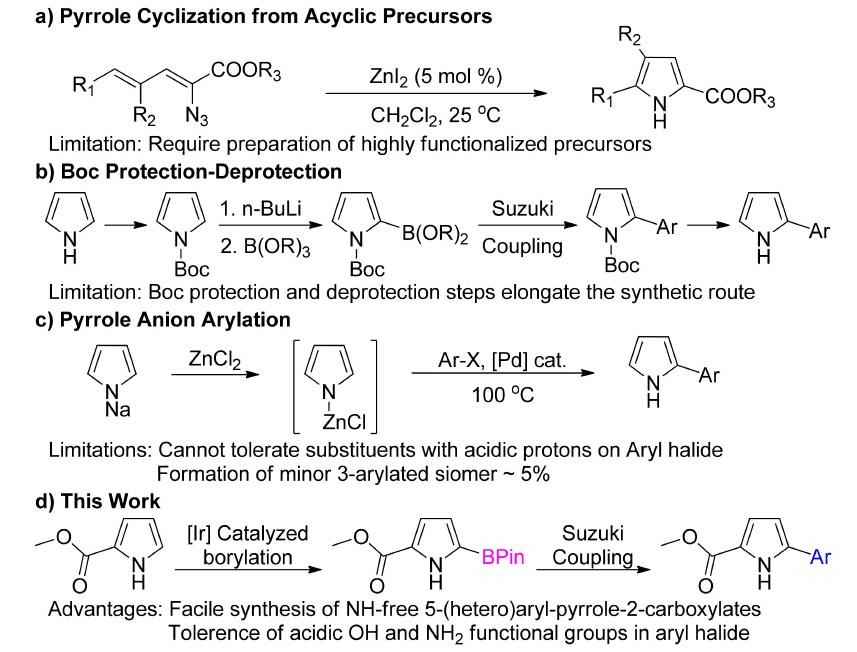
Figure 2. Various routes for the synthesis of aryl substituted